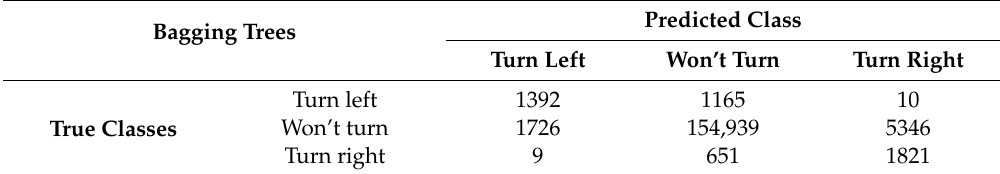
Table 4. The confusion matrix of the bagging trees trained by 61-day data.